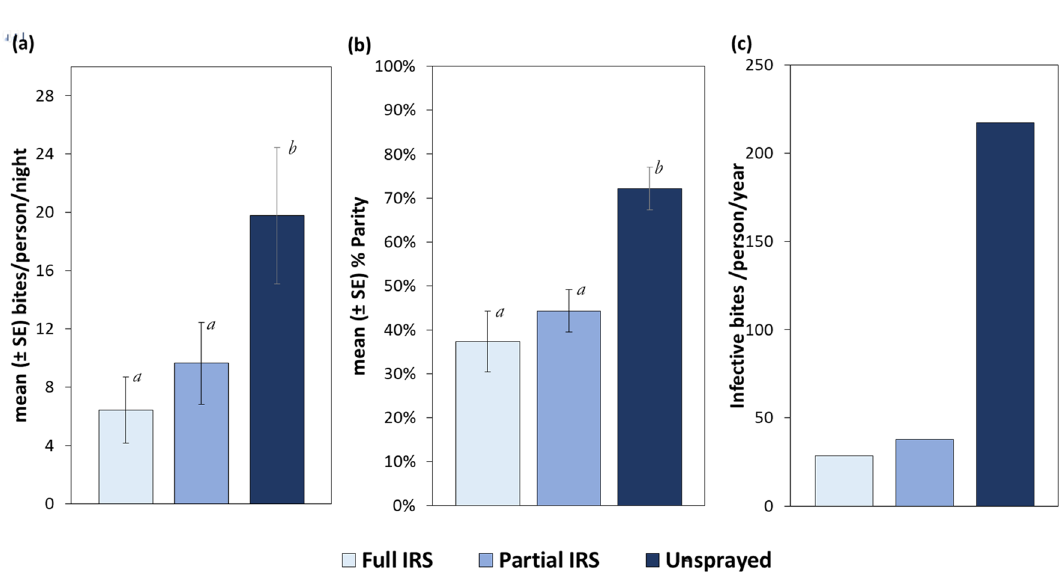
Figure 5. Entomological indices of malaria transmission estimated in full and partial IRS and unsprayed control communities in a village scale trial in northern Ghana, recorded from March–December 2019. ( a ) Human biting rates (HBRs), expressed as mean bites per person per night, of An. gambiae s.l. by treatment. ( b ) Mean parity rates of An. gambiae s.l. recorded from study sites. ( c ) Entomological inoculation rates (EIR) of An. gambiae s.l., expressed as total number of infective bites per person per year, by treatment. The annual EIR was estimated from the sum of monthly EIRs between March and December. Different letters on error bars denote statistically significant differences between means of biting and parity rates at p = 0.05. Statistical analysis for EIR were not of An. gambiae s.l. in 2019 in both fully (39%) and partially sprayed communities (45%) were significantly lower ( p < 0.001) than the control sites (66%), but the difference between parity rates in partially and fully sprayed areas was not significant ( p = 0.66) (Fig. 5B).